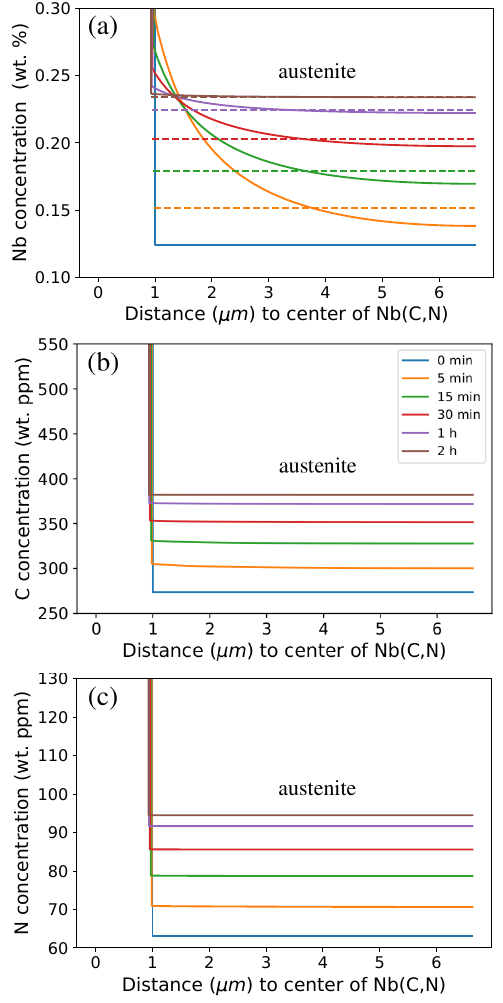
Figure 4. Concentration profiles during isothermal holding at 1473 K obtained using DICTRA where the Nb(C,N) region is on the left-hand side (0 µm corresponds to the center of spherical Nb(C,N) precipitate) and austenite is on the right-hand side: ( a ) Nb (mean Nb concentrations in austenite are given by dashed lines), ( b ) C, and ( c ) N (nine-element calculation (full composition) using the TCFE9 database). The starting point (0 min) corresponds to equilibrium at 1373